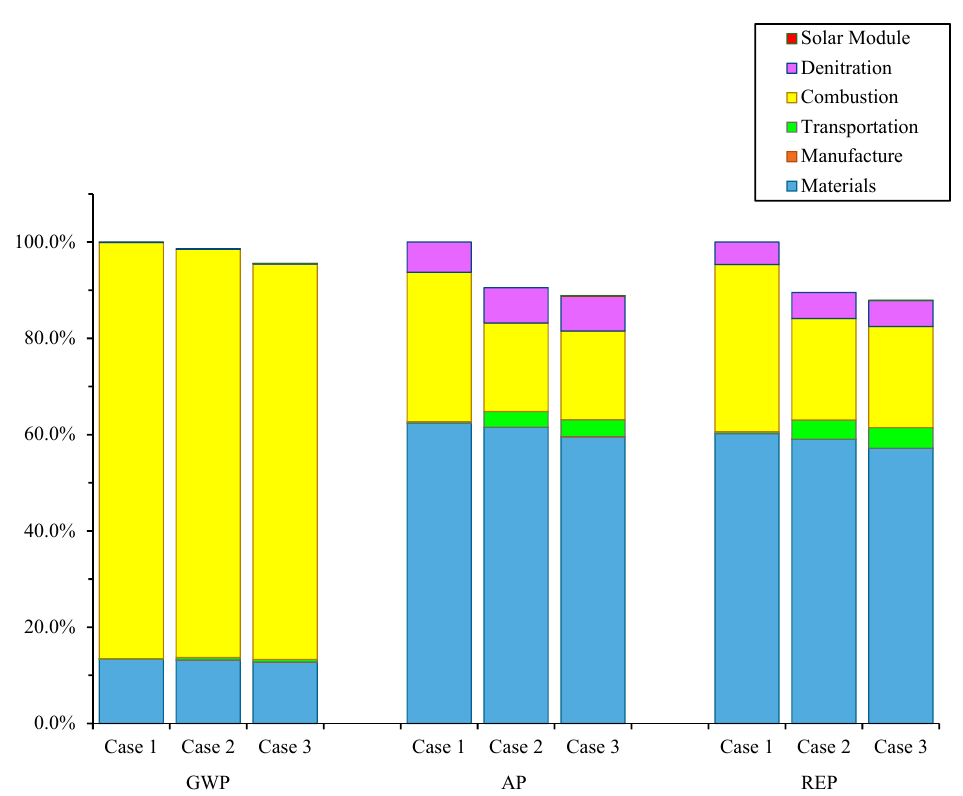
Figure 8. Normalized Life cycle GWP, AP, and REP emissions. Table 20. The weight vector of PEC, GWP, AP, and REP in different regions and from different perspectives.